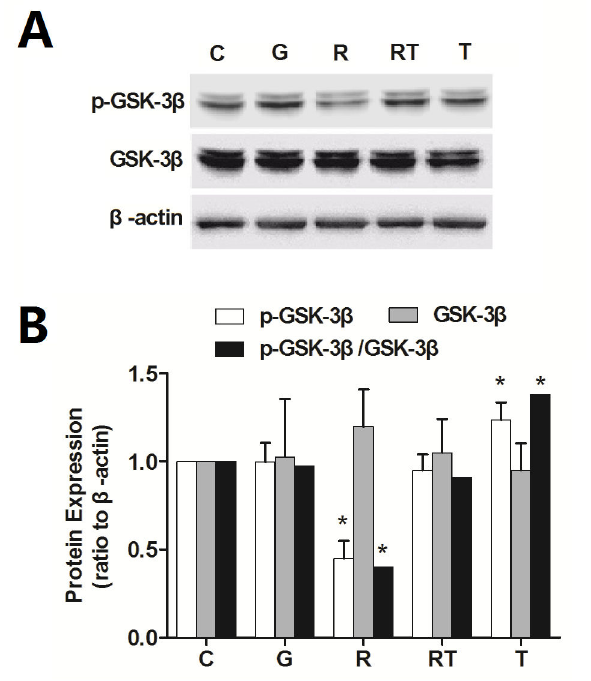
Figure 2. Remifentanil infusion increases the GSK-3β activity in spinal dorsal horn. The total GSK-3β and phosphorylated GSK-3β in spinal dorsal horn were tested by Western blot. β-actin was used as the internal standard (a). The band intensity of C group was assigned a value of 1. Remifentanil resulted in significant decreases of pGSK-3β (ser9) and p-GSK-3β (ser9)/GSK-3β ratio, but had no effect